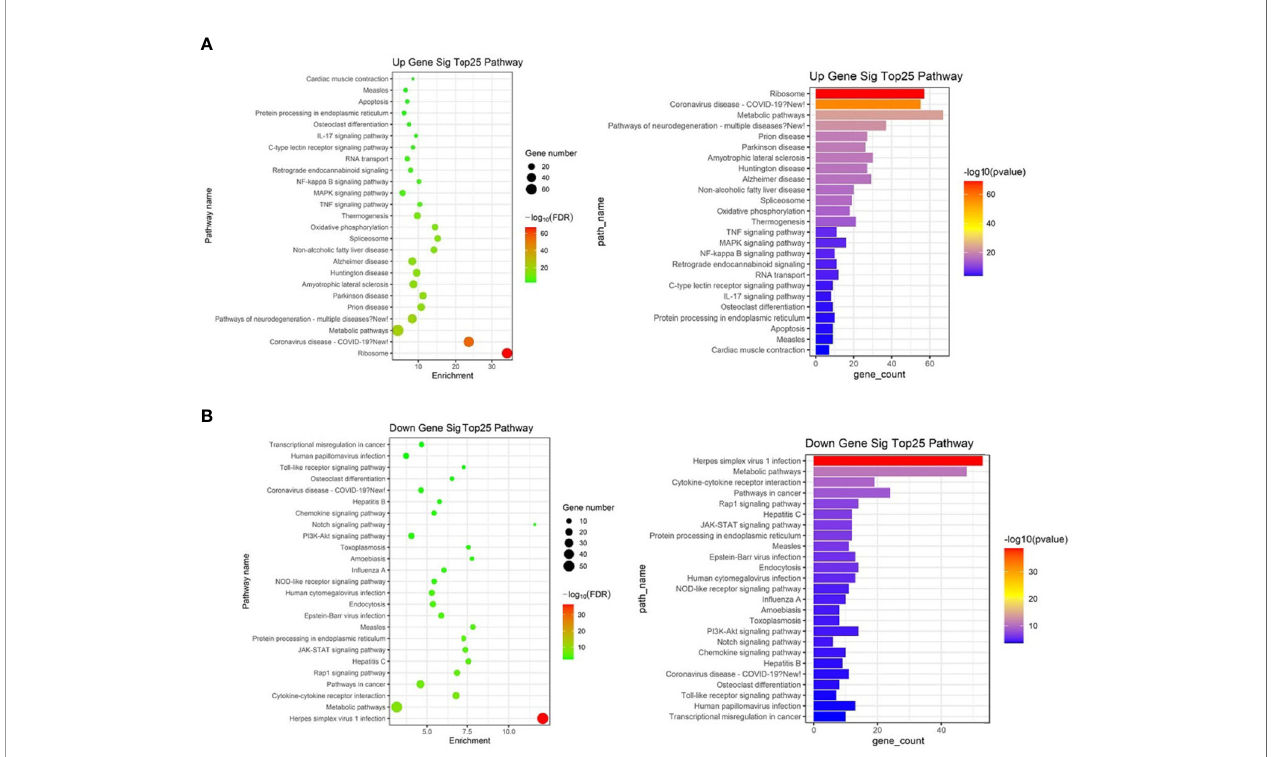
FIGURE 8 | The top 25 signi fi cantly enriched KEGG-pathway analyses of overlapped target genes of differentially expressed miRNAs in spleen lymphocytes of Balb/C mice (Kyn stimulated vs negative control). (A) Up gene KEGG analysis. (B) Down gene KEGG